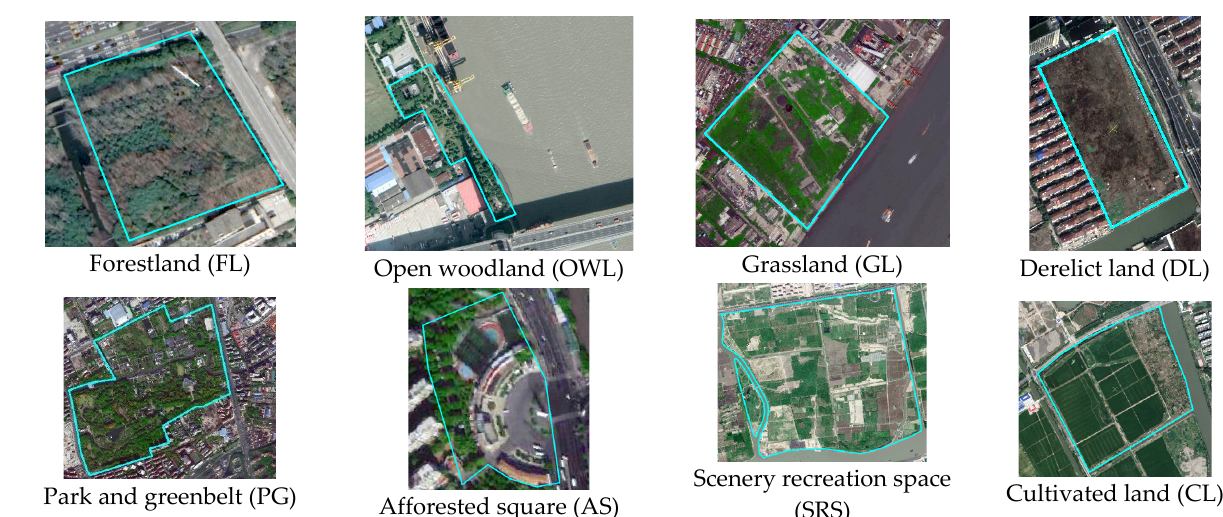
Figure 4. Identification of greenspace types and morphological characteristics in the riverfront area. Table 1. Classification system of greenspace in the urban riverfront area.